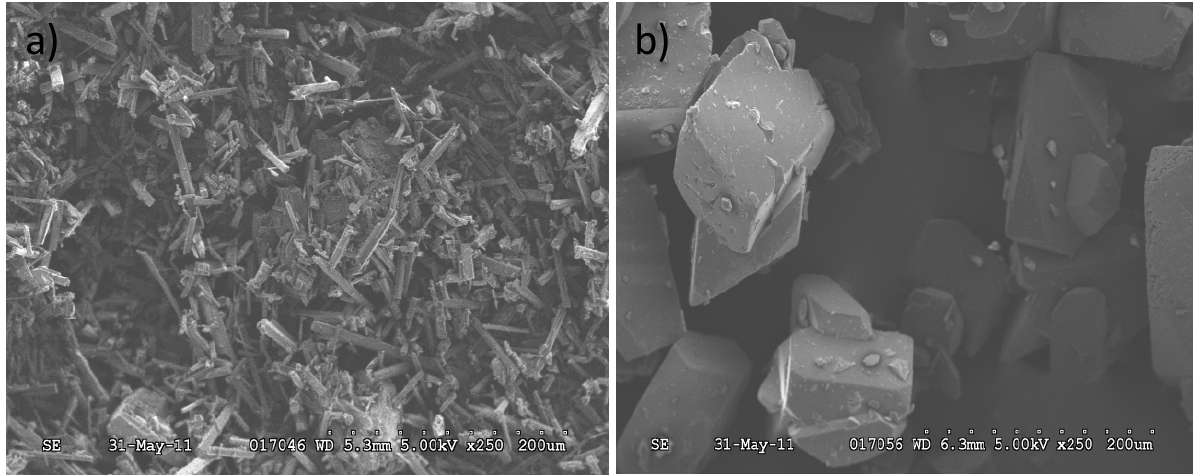
Figure 3. SEM pictures of polymorphic forms of carbamazepine: ( a ) Form II; ( b ) Form